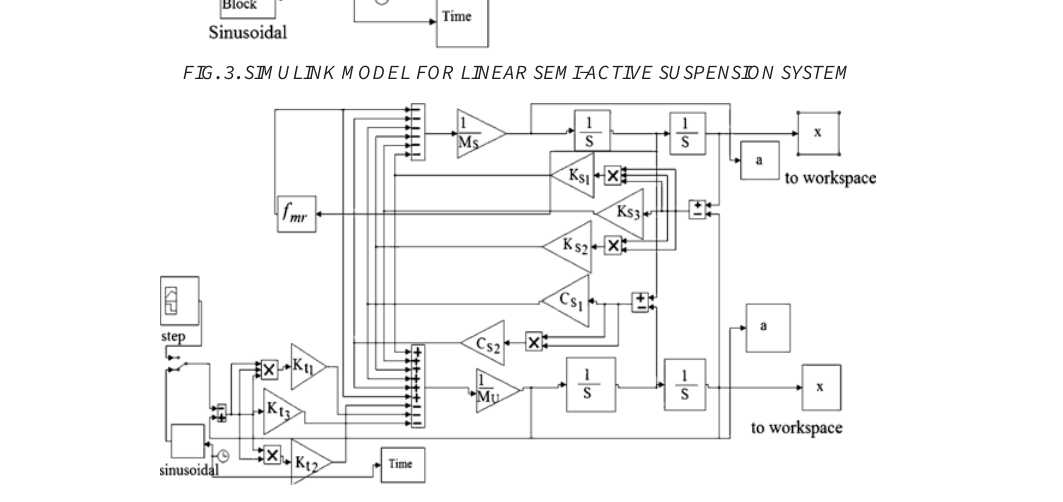
FIG. 4. SIMULINK MODEL FOR NON-LINEAR SEMI-ACTIVE SUSPENSION SYSTEM